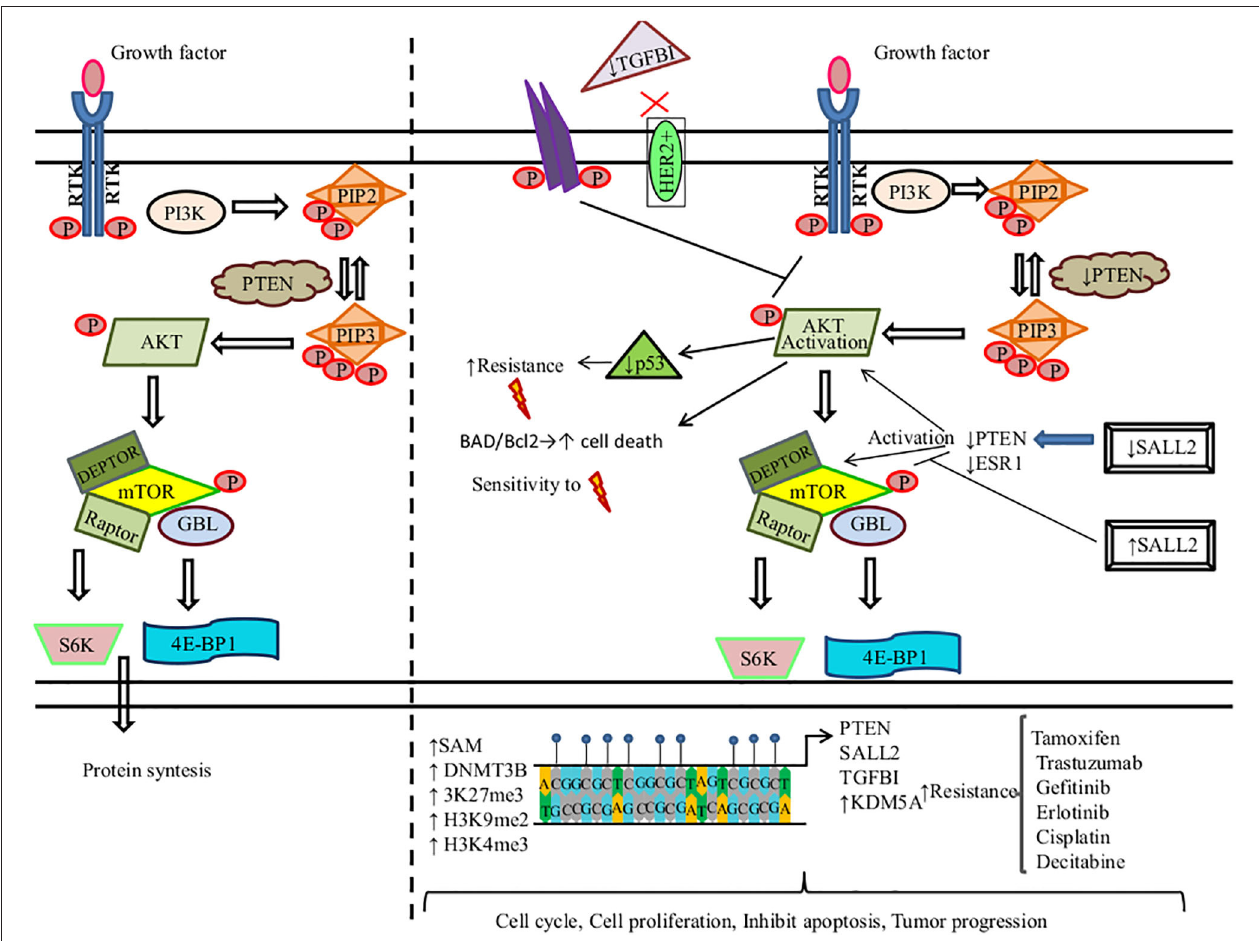
FIGURE 2 | DNA methylation regulates the PI3K/PTEN/AKT/mTOR signaling pathway in the resistance to therapy in cancer. (Left) PI3K induces the phosphorylation and activation of AKT/mTOR. This transduction signal begins with the activation of the membrane tyrosine kinase receptors (RTKs) or G-protein-coupled receptors, which promotes the change of phosphatidylinositol (4,5)-bisphosphate (PIP2) in phosphatidylinositol (3-5)-trisphosphate (PIP3). The activation of PI3K (phosphoinositide-3-kinase) is regulated by the phosphatase and tensin homolog (PTEN) by dephosphorylating PIP3 into PIP2. (Right) We show the aberrant methylation of the PTEN, Spalt-like transcription factor 2 (SALL2), transforming growth factor beta-induced protein (TGFB1), and Lysine (K)-specific demethylase 5A (KDM5A) genes through the high expression of methyltransferase (DNMT3B), s-adenosylmethionine (SAM), H3K27me3, H3K9me2, and H3K4me3, promoting a continued activation of the PI3K/AKT/mTOR signaling pathway associated with resistance therapy in solid tumors. , phosphorylation; ↑ , increase; ↓ , decrease;